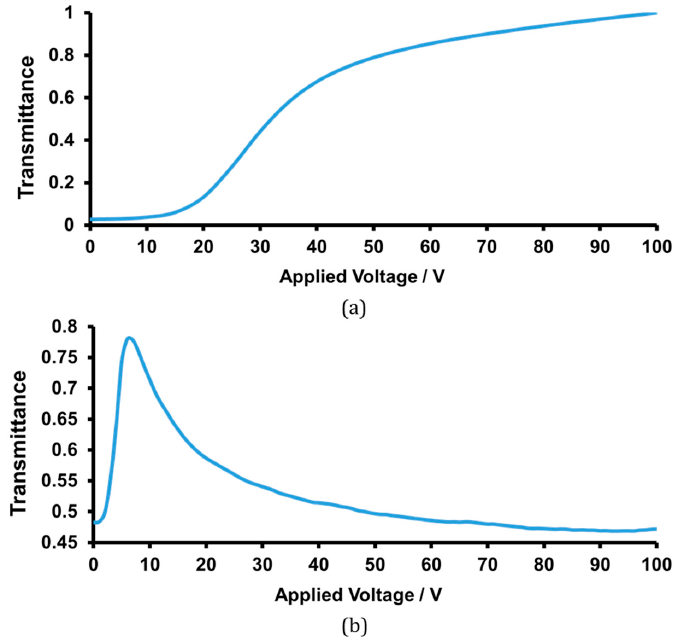
Figure 2. T-V curves measured for PDLC films with ( a ) small and ( b ) large LC droplets in the presence of an AC voltage with 1 kHz.